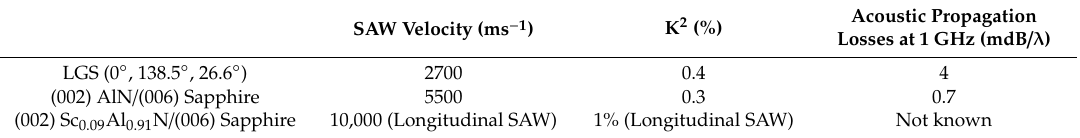
Table 1. Comparison between SAW properties of LGS, AlN/sapphire and Sc 0.09 Al 0.91 N/sapphire materials. SAW Velocity (ms − 1 )